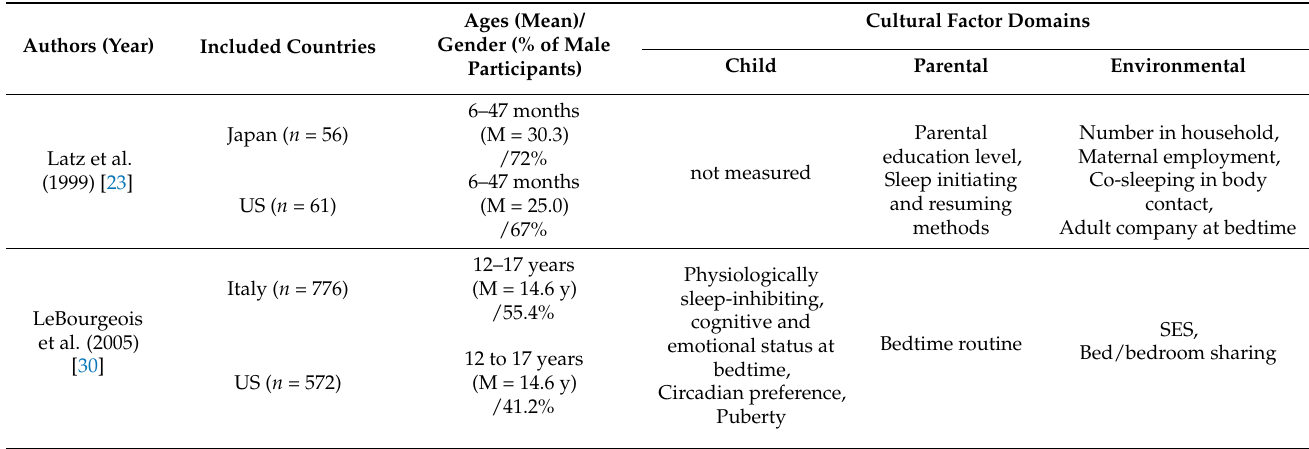
Table 3. Cultural factors examined with sleep duration or sleep